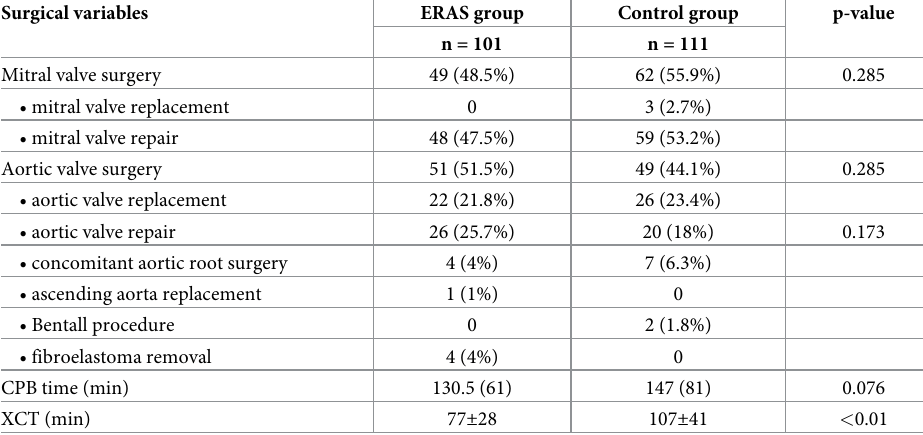
Table 2. Intraoperative and postoperative management. Surgical